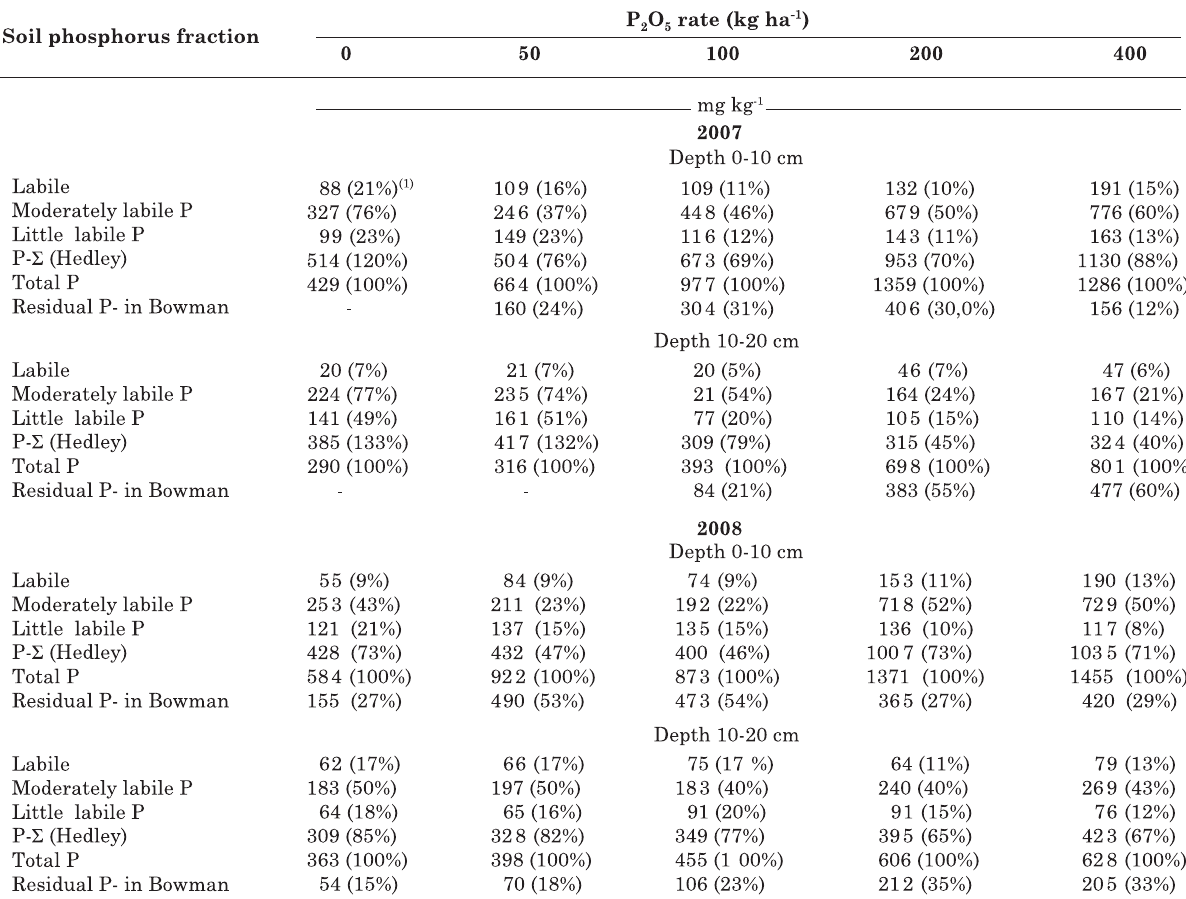
Table 3. Phosphorus fractions in a dystrophic Red Latosol (Oxisol) under coffee fertilized with different P levels, in 2007 and